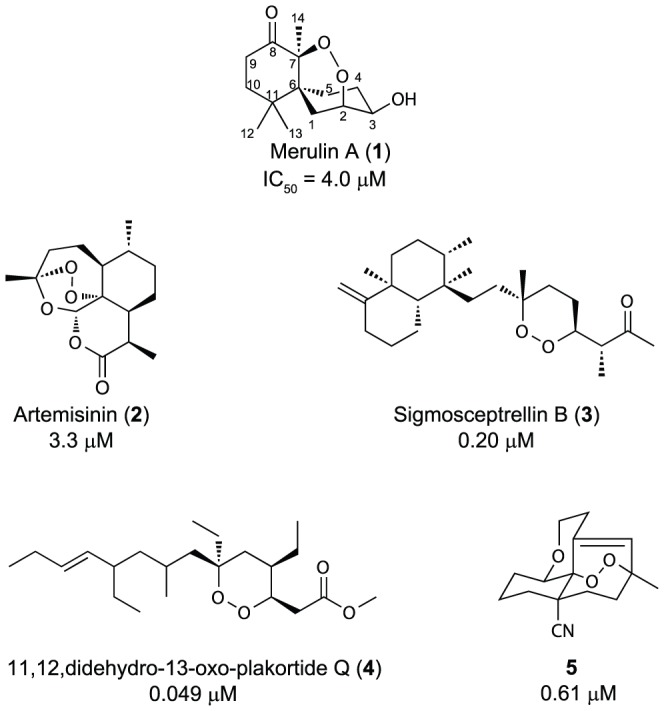
Reported anti-trypanosomal endoperoxides.